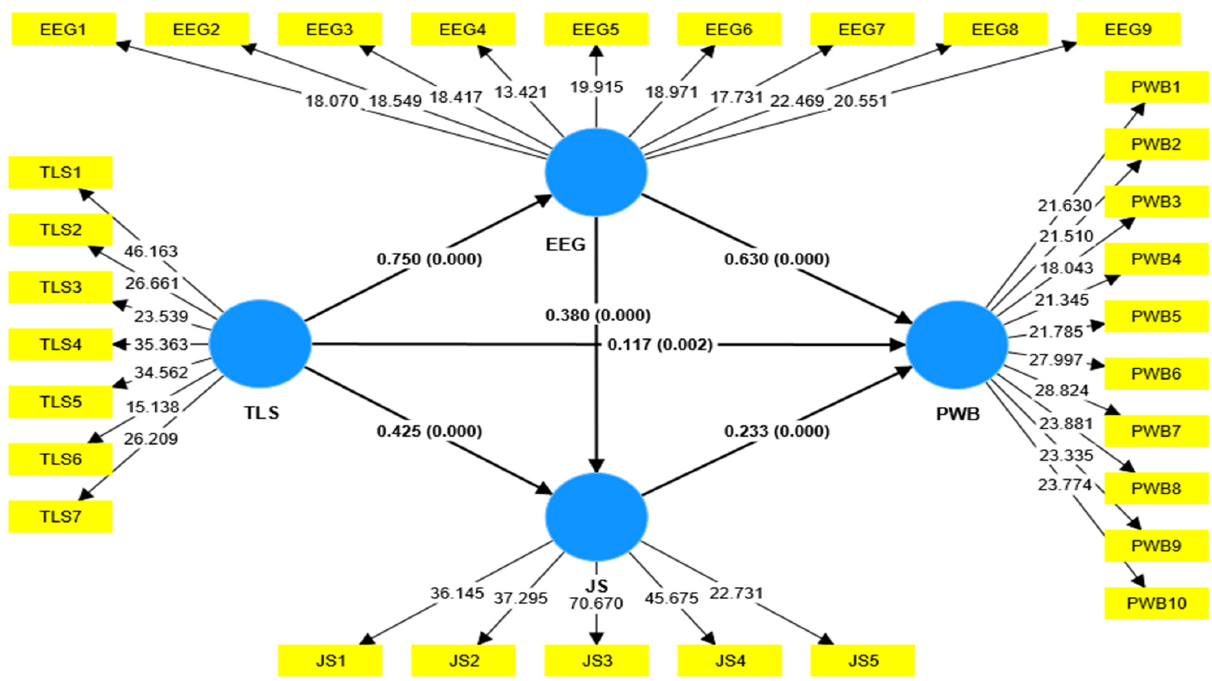
Figure 2. The structural